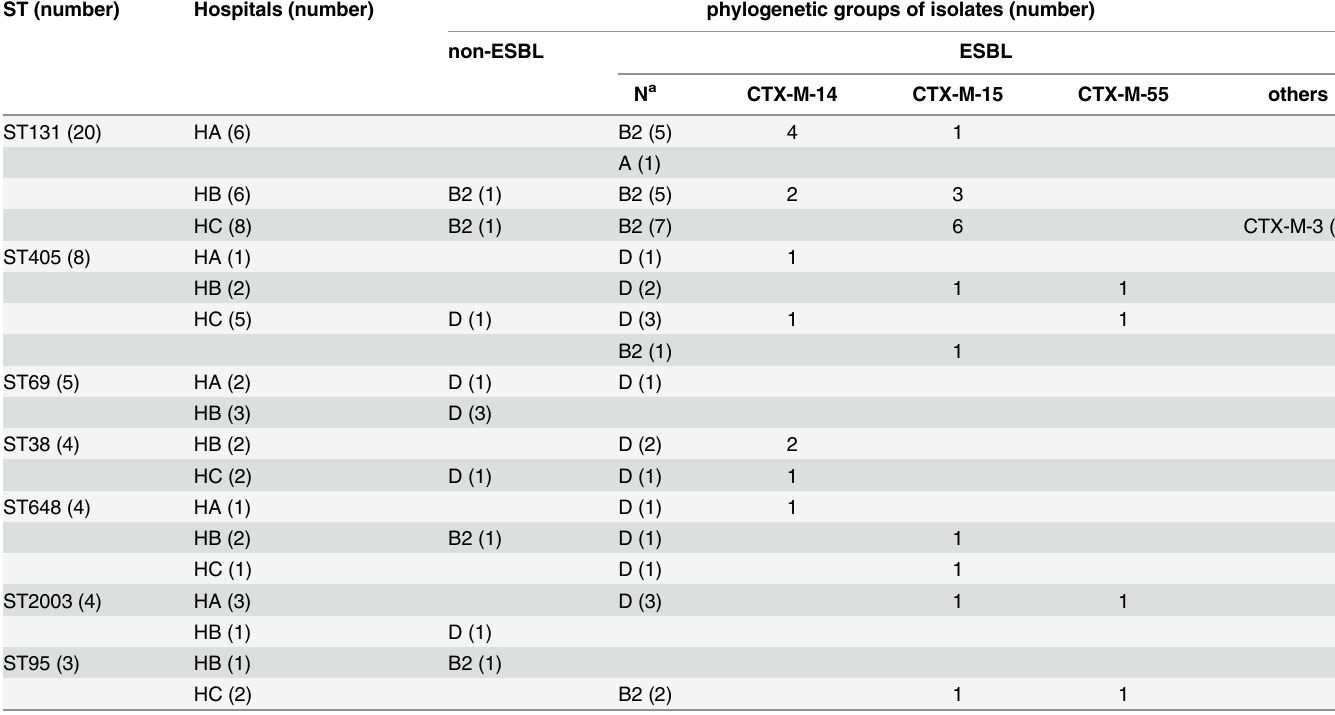
Table 5. The Distributions of Main Genotypes in Three